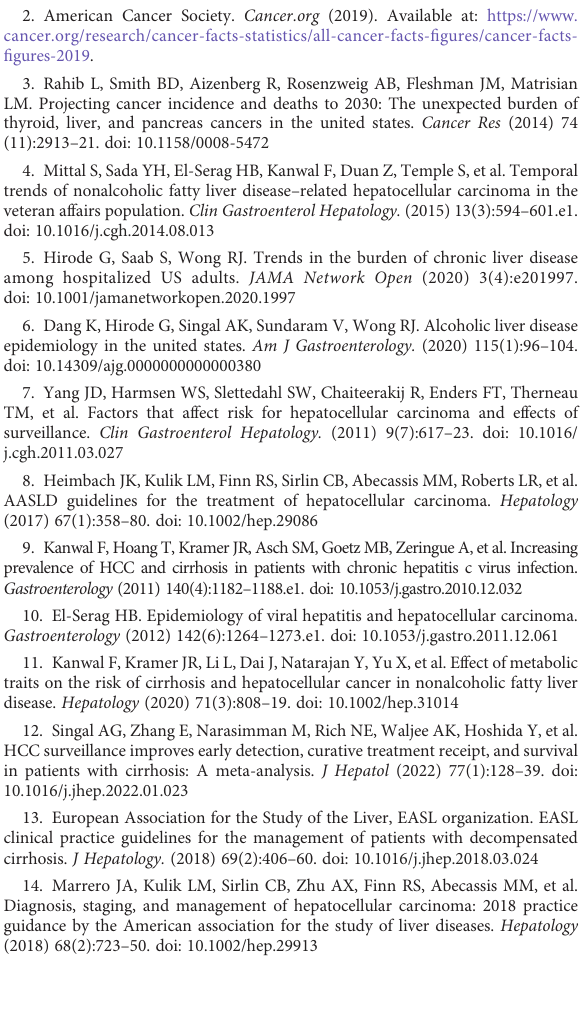
and CCA tumors. Control-all includes all samples corresponding tonon- cancer liver cirrhosis patients and those of normal healthy controls. SUPPLEMENTARY TABLE 6 All the variants called from the 46 samples were fi ltered by depth (>=5) and quality score (>=20), and then annotated with SnpSift 5.1d and dbNSFP 4.3a to get clinvar information. There are 6,109 variants which had been reported in clinvar database. Clinical trait and clinical signi fi cance of each variant are indicated in the table. POS: location of variant;ID:dbSNP id; REF: Reference sequence; ALT: Altered sequence; QUAL: Quality of variant calling in phred score (-log10[probability offalse calling]);INFO: information of variant including annotation by SnpSift. SUPPLEMENTARY TABLE 7 Characteristics of HCC and CCA patients whose specimens were